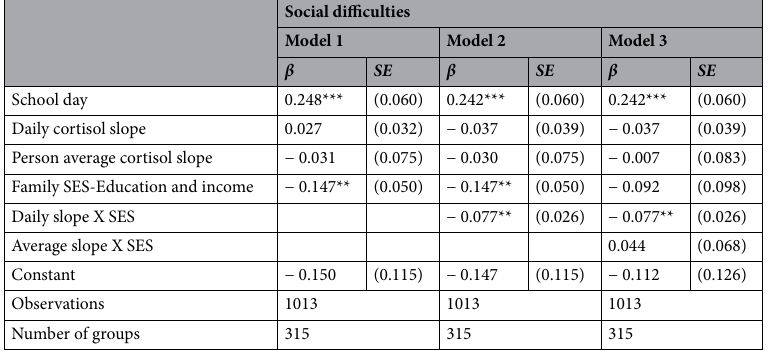
Table 2. Multilevel linear regression models. Standard errors in parentheses. ***p < 0.001, **p < 0.01, *p < 0.05, Models additionally control for gender, age, and race/ethnicity (not shown).